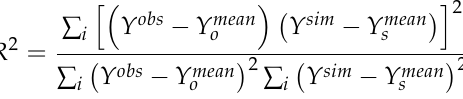
Table 1. Parameters and their range selected to calibrate the model using Sequential Uncertainty Fitting 2 (SUFI 2) within Soil and Water Assessment Tool Calibration Uncertainty Program (SWAT CUP), their sensitivity ( t -stat and p -value determine the rank for each parameter) and best fitted value used to calibrate and validate the SWAT model.